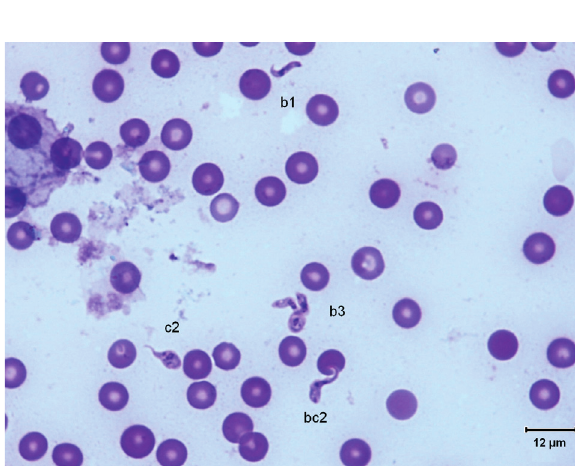
Fig. 10. – Free forms and Rosette of T. (Nannomonas) isomorph. Photo by Sophie Ravel. Several congolense -forms: thin and dark with a free flagellum (upper left), medium width and colour, with a large undulating membrane (centre left), broad and light in colour (upper right).